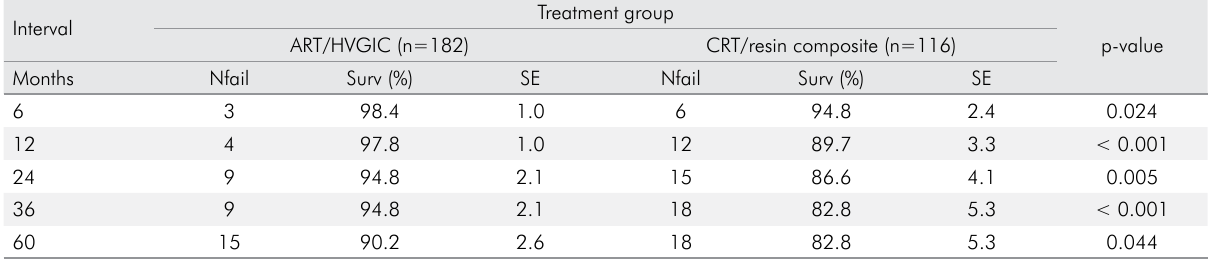
Table 1. Cumulative survival percentages, Jackknife standard error (SE) and p-values after 5 years for all restorations placed in patients with disability by treatment group.